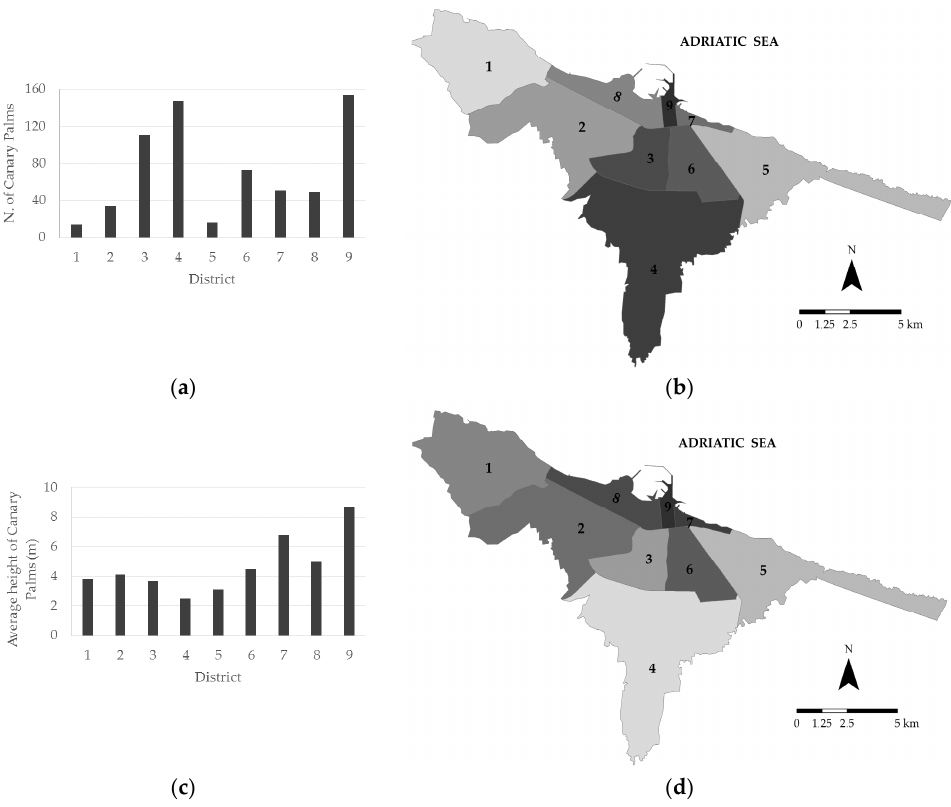
Figure 2. Number of Canary Palms, per district ( a ), and their spatial distribution in the City of Bari ( b ). Average height of Canary Palms, per district ( c ), and spatial distribution in the City of Bari ( d ). Source: Urban forestry Department—City of Bari, 2014 (Our data processing).